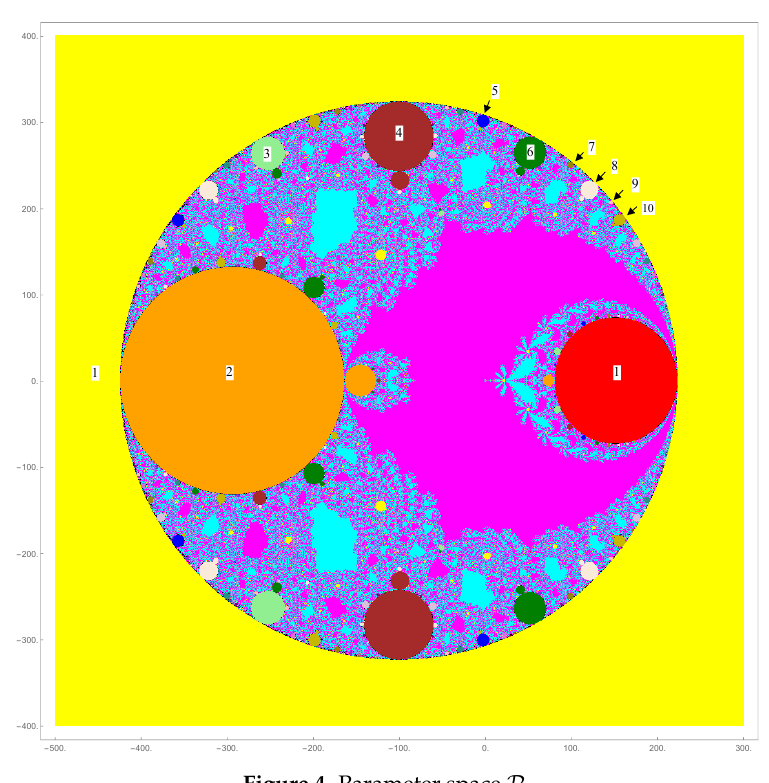
Figure 4. Parameter space P